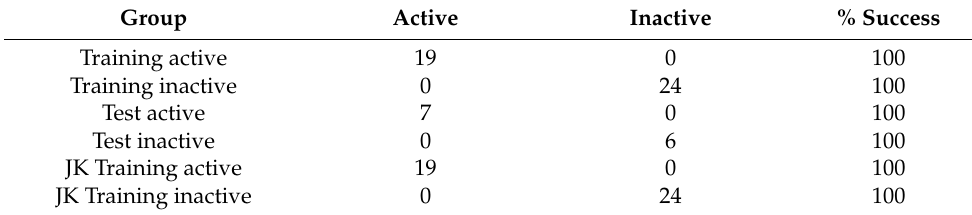
Table 4. Classification matrix for DF MRSA4 .